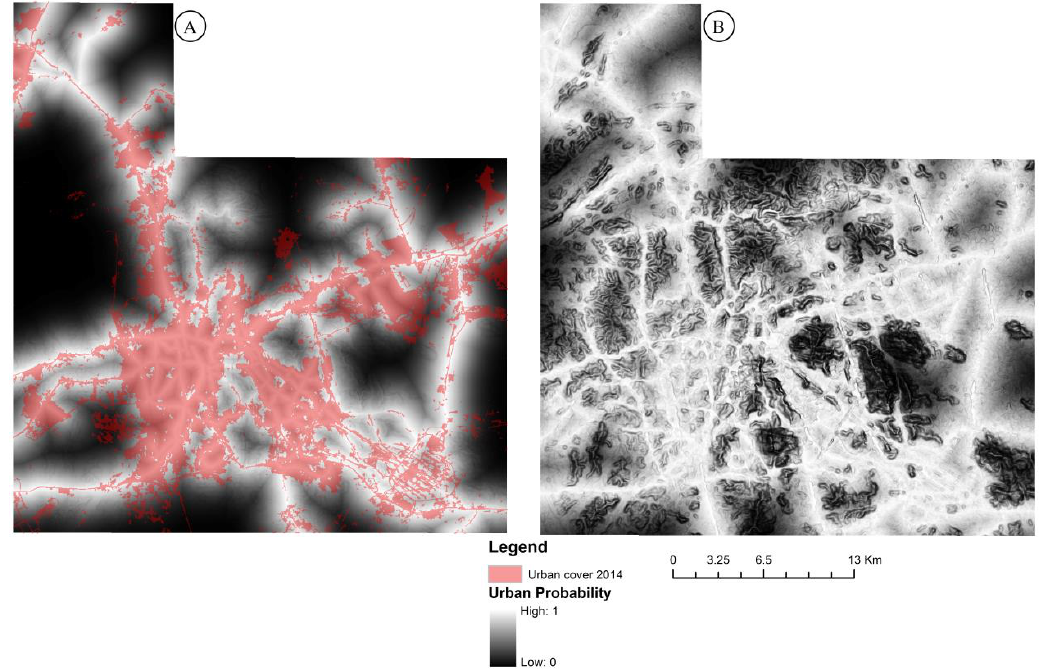
Figure 7. Urbanization probability maps in Makkah ( A ) a comparison of the urban probability in 1985 and urban areas in 2014; ( B ) urban probability in 2014